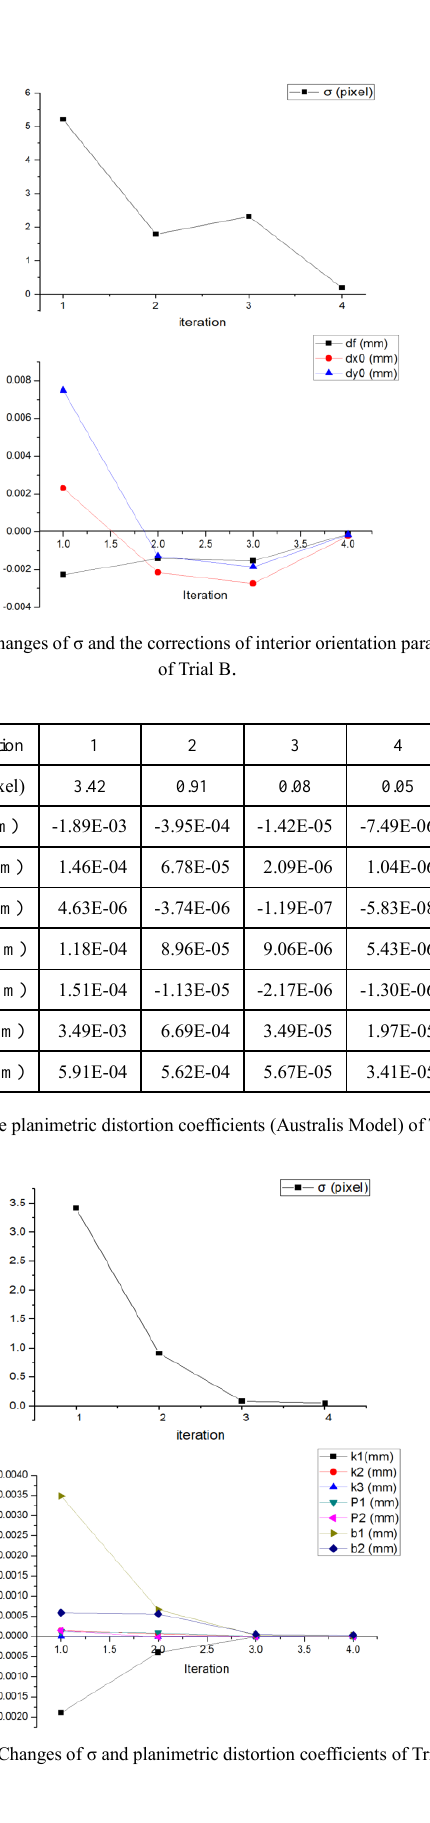
Table 8. The planimetric distortion coefficients (Australis Model) of Trial